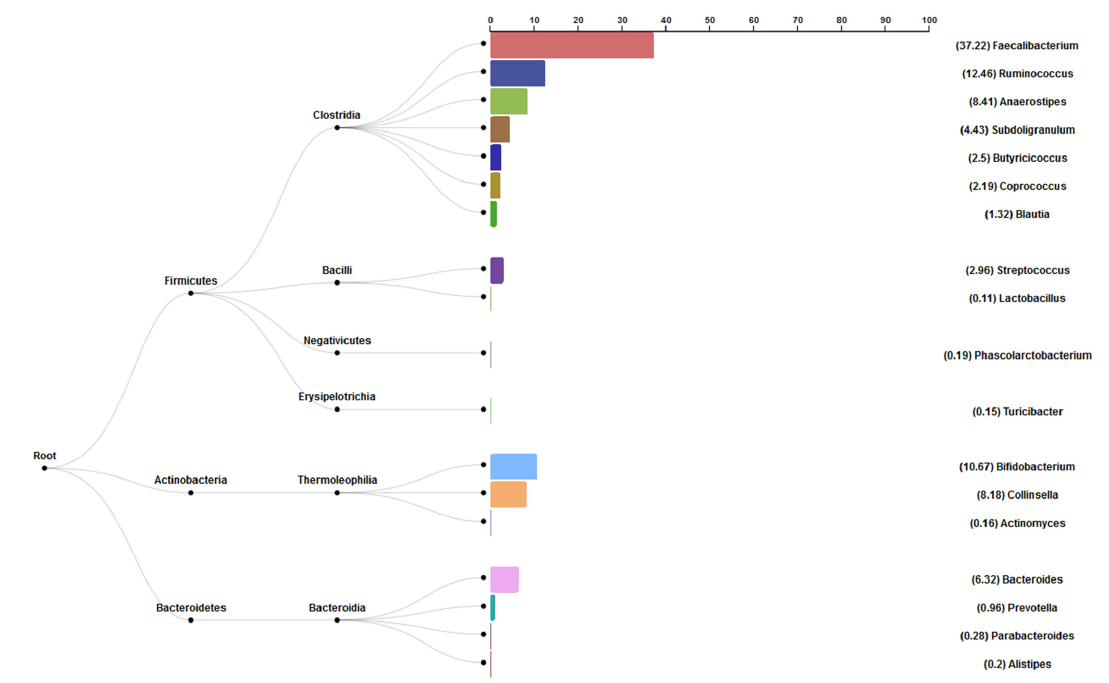
Figure 5. Bacterial abundance in CRC-prior treatment group.